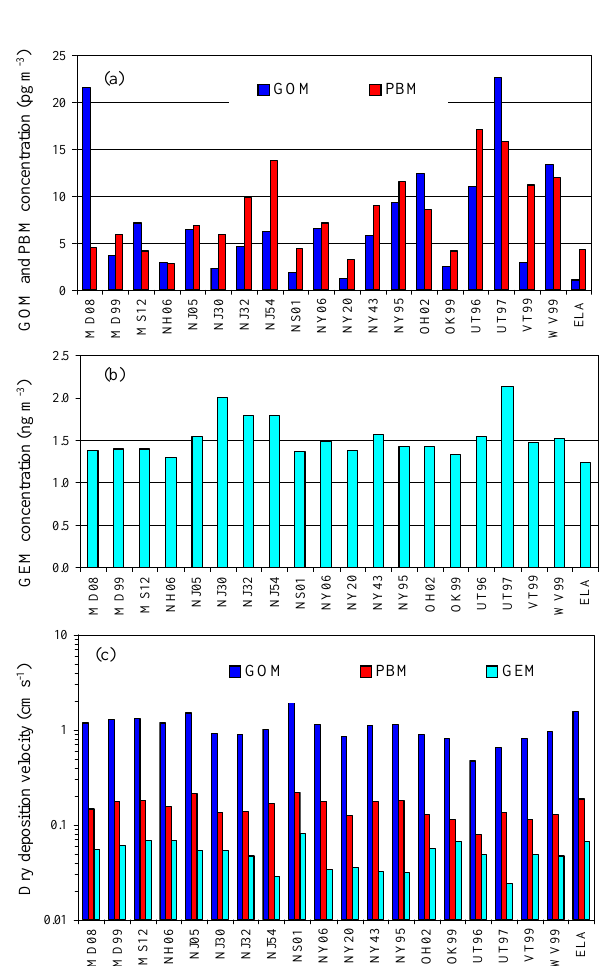
Fig. 2. Annual average concentrations for GOM, PBM (pgm − 3 ) and GEM (ngm − 3 ) and annual dry deposition velocity ( V d in cms − 1